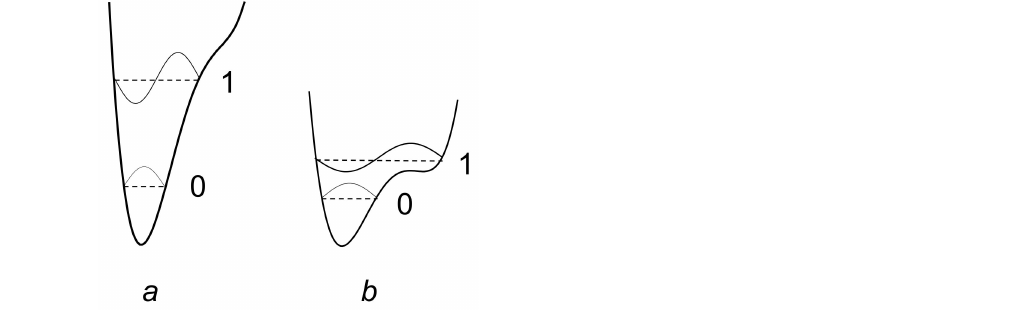
Figure 8. Schematic representation of the ground and excited vibrational states for a weak ( a ) and moderate ( b ) bonds.